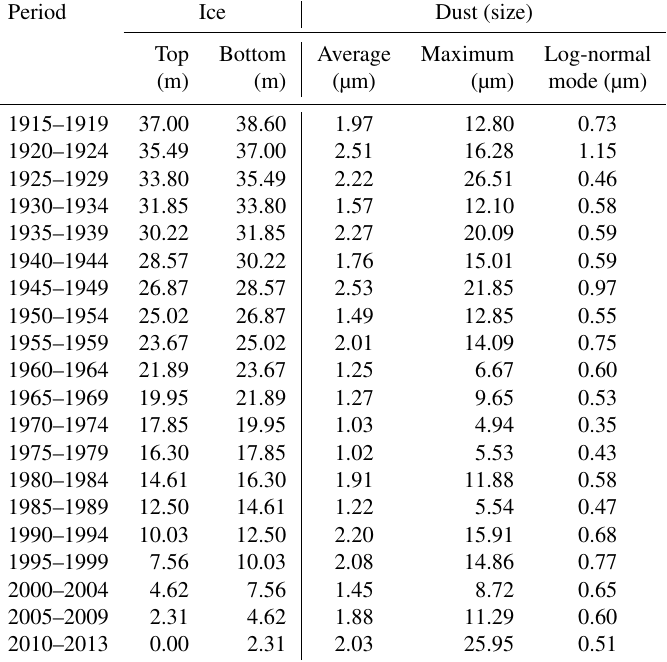
Table 1. Description of the SIGMA-D ice core dust samples.